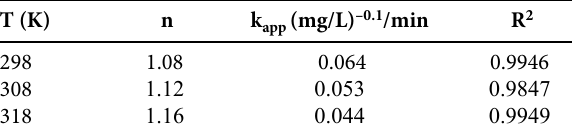
Table 1. The reaction orders and rate